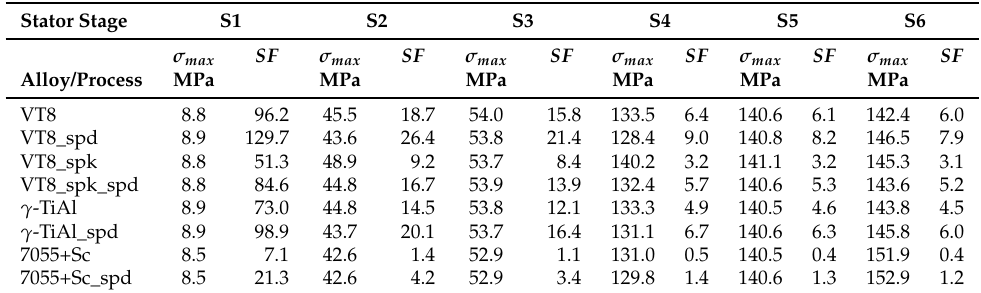
Table 6. Equivalent stress and static safety factor of vanes made from candidate